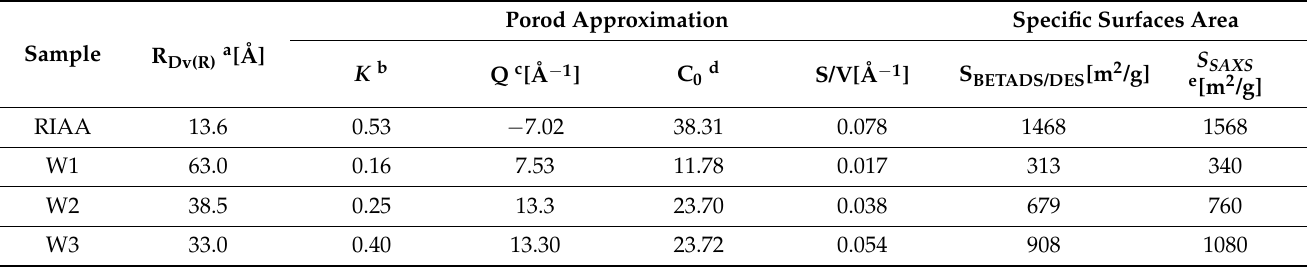
Table 2. SAXS structural parameters for the investigated carbon samples.